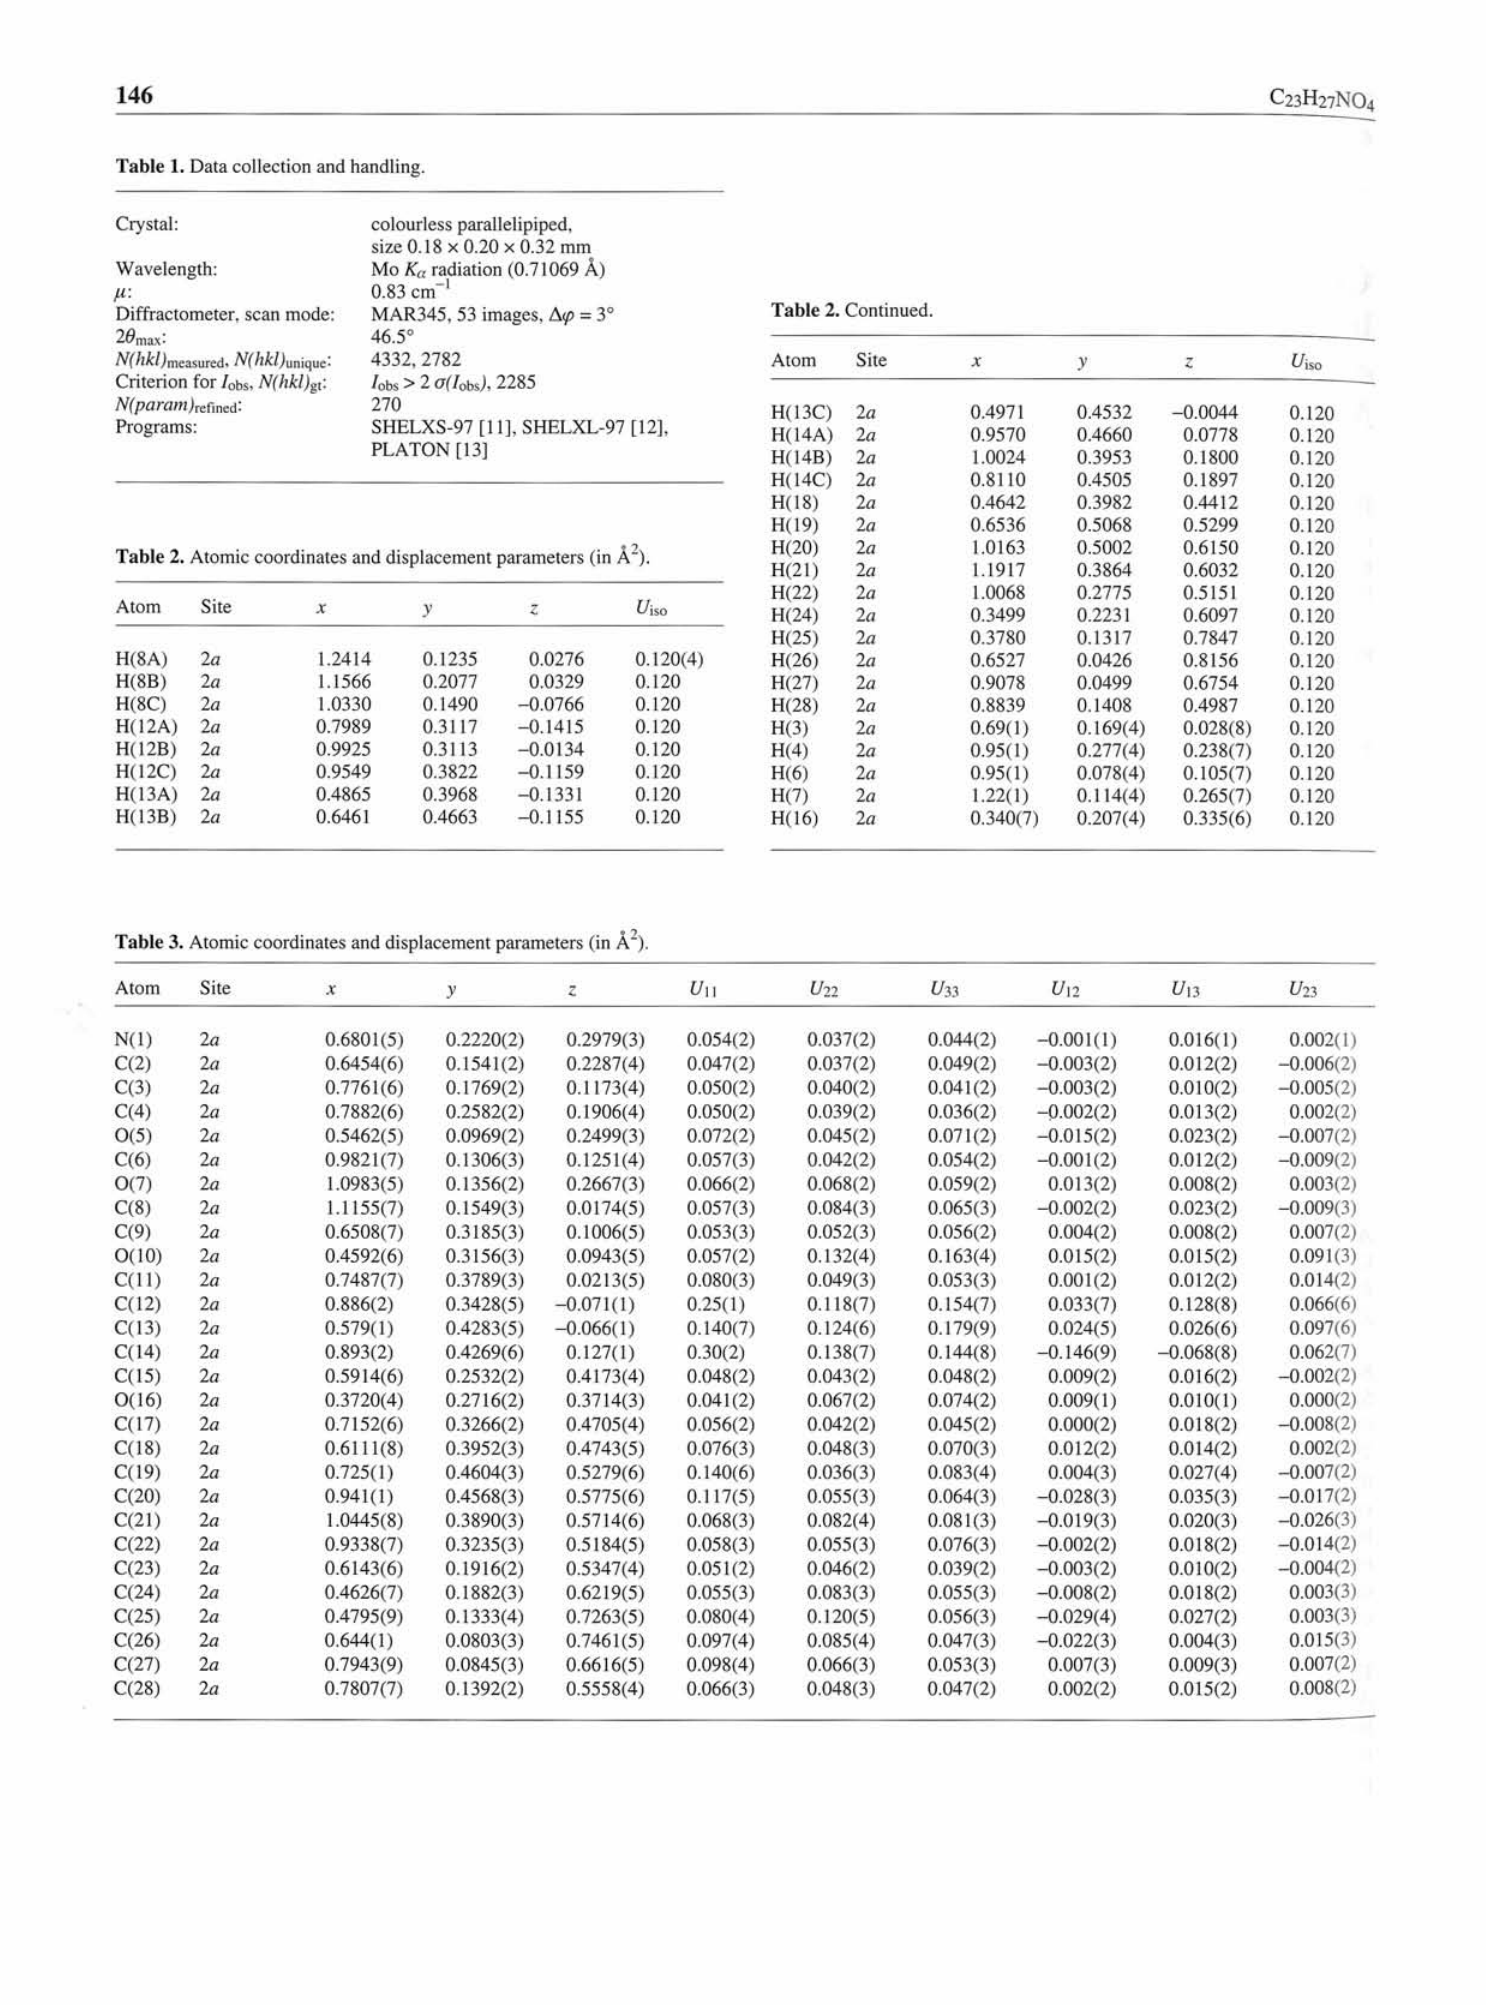
Table 1. Data collection and handling.